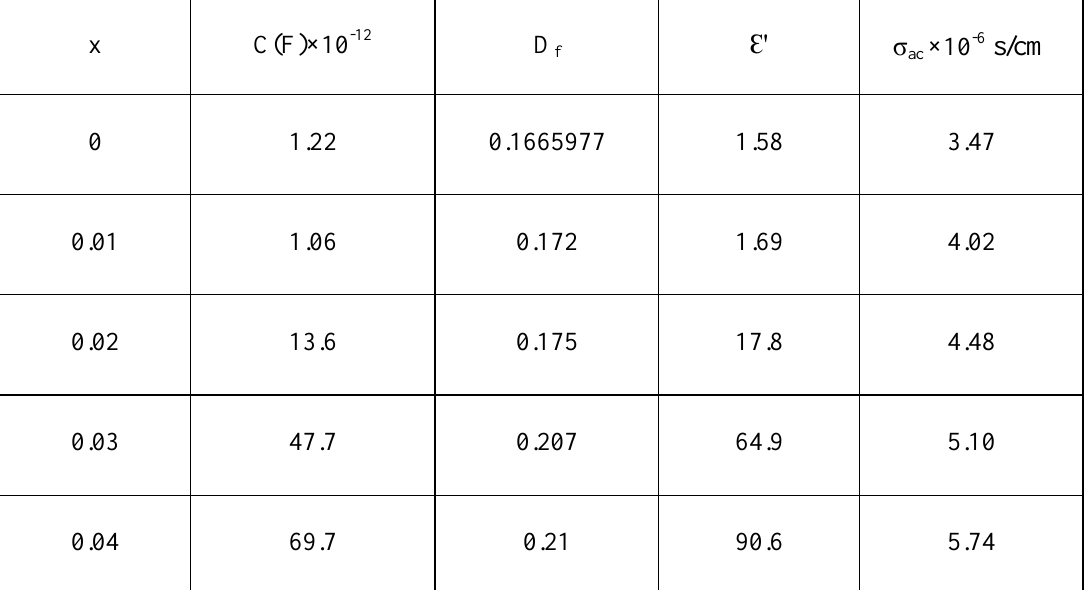
Ԑ' ζ ×10 -6 s/cm ac